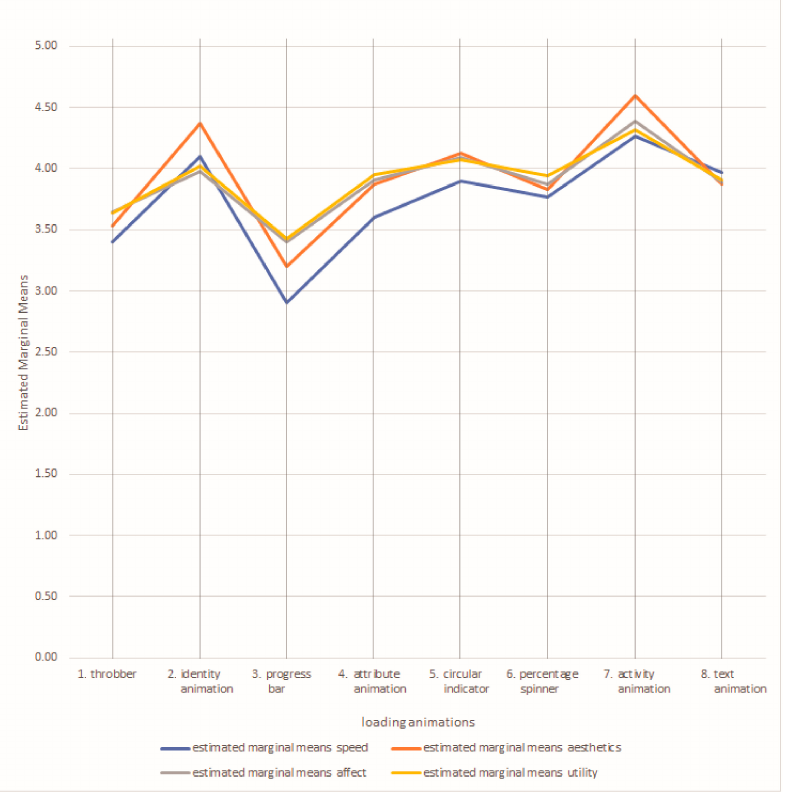
Figure 2. The estimated marginal mean values of the four variables of wait-time-animation evaluation for each of the eight proposed designs.